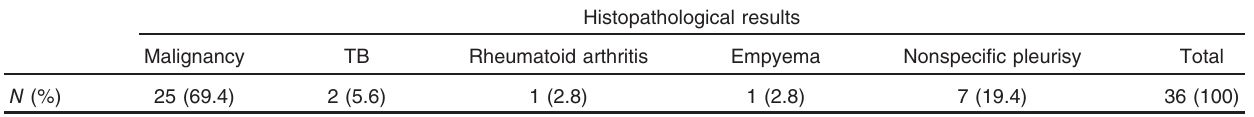
Table 4 Histopathological results of different pleural biopsies of studied patients